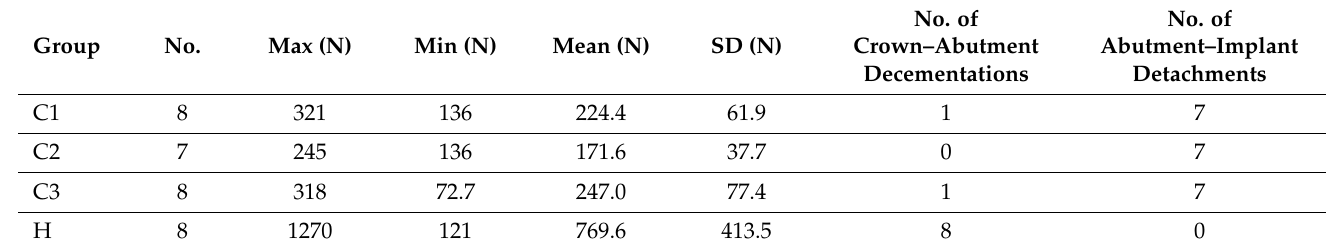
Group Table 3. Mean values for failure loads (pull-off forces) of the test groups (N = 31).